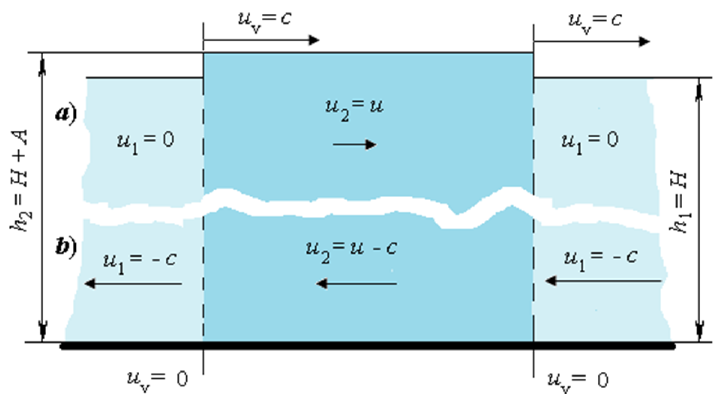
Figure A3. Schematic drawing of the motion of a gravitational wave in various frames of reference: ( a ) in a fixed (laboratory) frame of reference; ( b ) in a moving (with the speed of a wave) frame of reference.